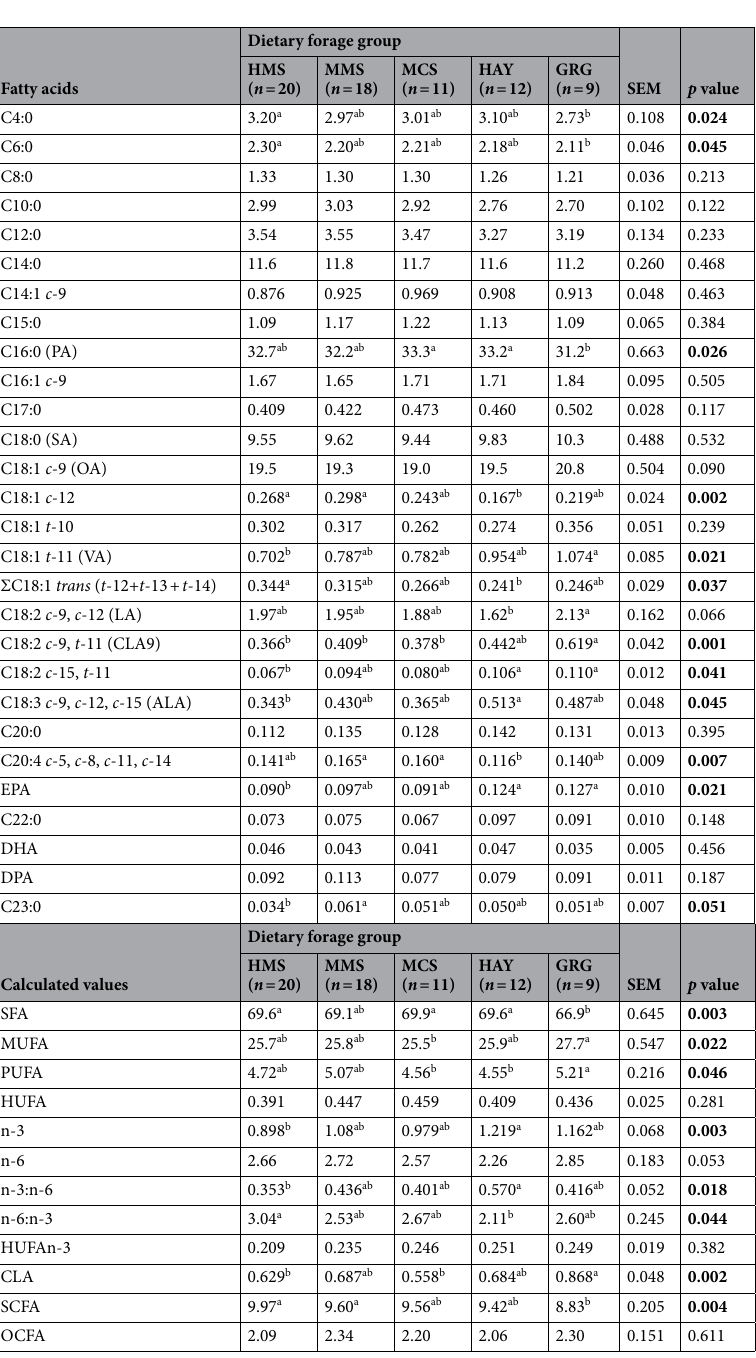
Table 3. Effect of dietary roughage source (forage group) on milk fatty acid (FA) profile (g/100 g of total quantified fatty acids). HMS , high maize silage; MMS , medium maize silage; MCS , mixed crop silages; HAY , grass and lucerne hays; GRG , green grass; SEM , standard error of the means. Fatty acids abbreviations: PA , palmitic acid; SA , stearic acid; OA , oleic acid; VA , vaccenic acid; LA , linoleic acid; CLA , conjugated linoleic acid; ALA , alpha linolenic acid; EPA , eicosapentaenoic acid (C20:5 c -5, c -8, c -11, c -14, c -17); DHA , docosahexaenoic acid (C22:6 c -4, c -7, c -10, c -13, c -16, c -19); DPA , docosapentaenoic acid (C22:5 c -7, c -10, c -13, c -16, c -19); SFA , saturated FA; MUFA , monounsaturated FA; PUFA , polyunsaturated FA; HUFA , highly unsaturated FA (double bonds ≥ 4); n-3, omega-3 fatty acids; n-6, omega-6 fatty acids; HUFAn-3, highly unsaturated FA n-3; CLA , conjugated linoleic acids; SCFA , short chain FA (≤ C10); OCFA , odd chain FA. a-b LSMeans in a row without a common superscript differ ( p <